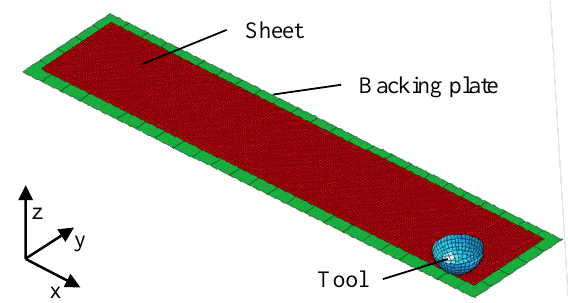
Figure 3. Setup for FE modeling of different tool path strategies and intrusion depths.